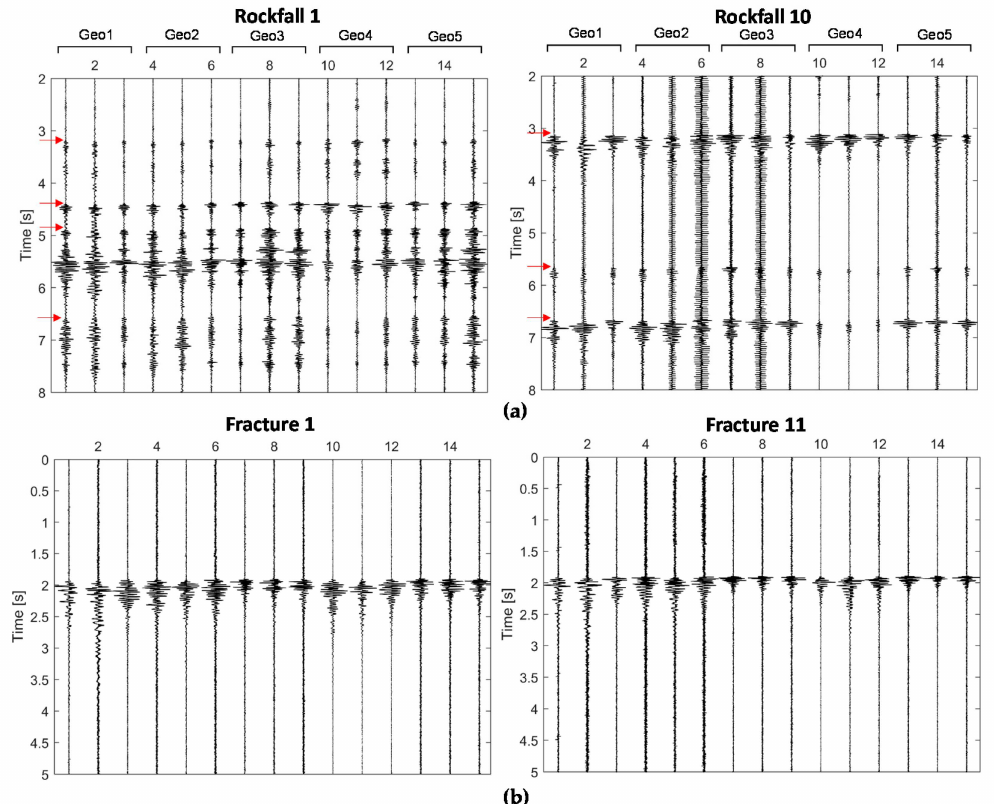
Figure 5. Microseismic signals recorded by the five 3C-geophones from ( a ) two suspected rockfalls (red arrows indicate the signals selected for picking and localization), and ( b ) two suspected fracture